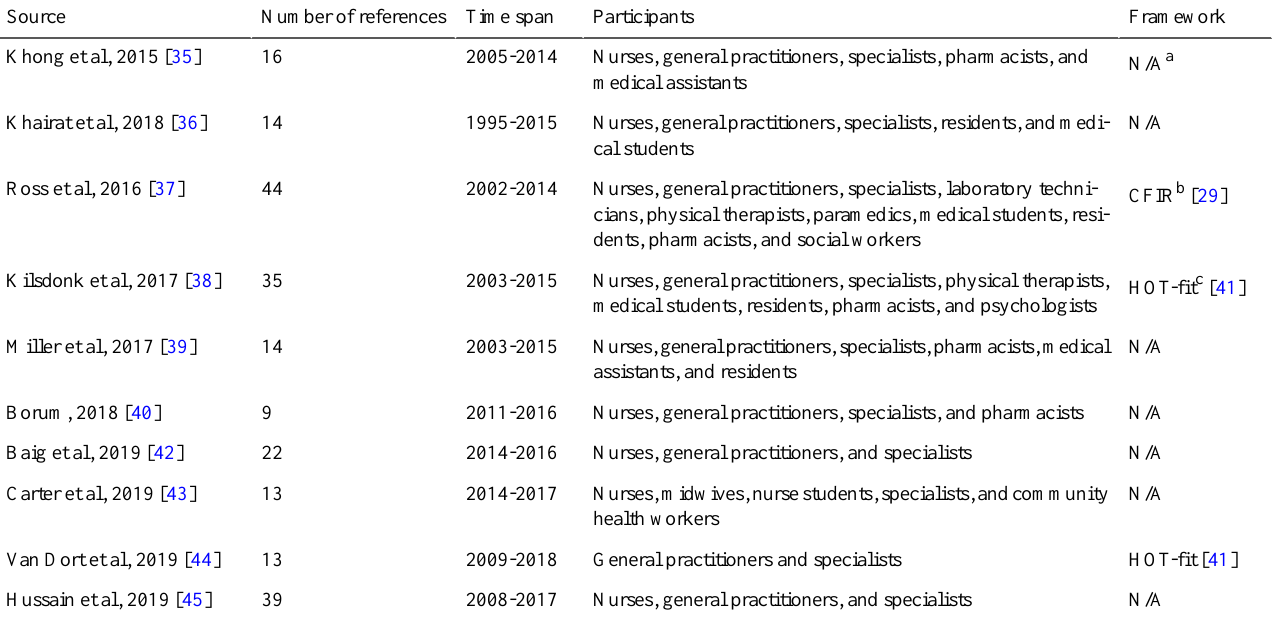
Table 1. Characteristics of included